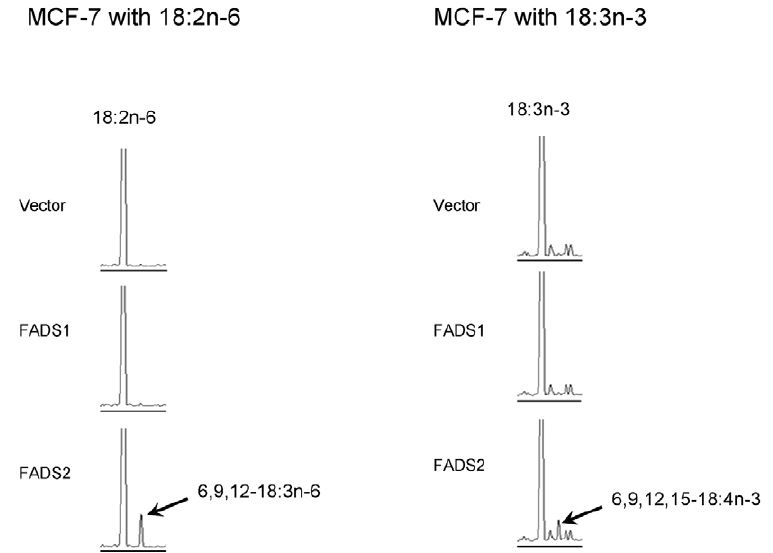
Figure 1. GC results of transfected MCF7 cells with18:2n-6 and18:3n-3 fatty acids. A: No product is seen in FADS1-transfected cells. B: FADS2 transfected cells D 6-desaturate 18:2n 2 6 R 18:3n 2 6 (9,12–18:2 R 6,9,12–18:2) and 18:3n–3 R 18:4n 2 3 (9,12,15–18:3 R 6,9,12,15–18:4).